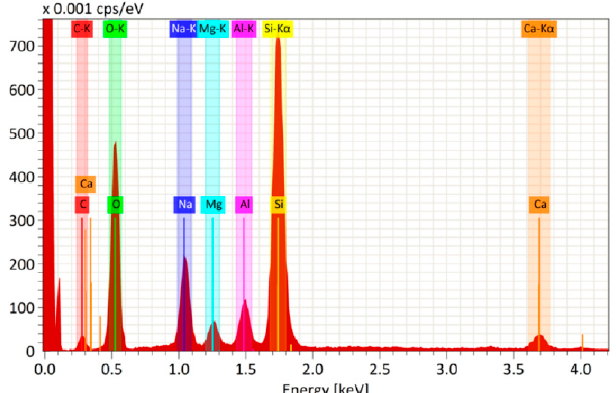
Figure 5. EDS spectrum of elemental analysis of glass with antireflective coating based on SiO 2 /TBAB (5 wt.%)/Gold (2.6 × 10 − 9 mol/mL).